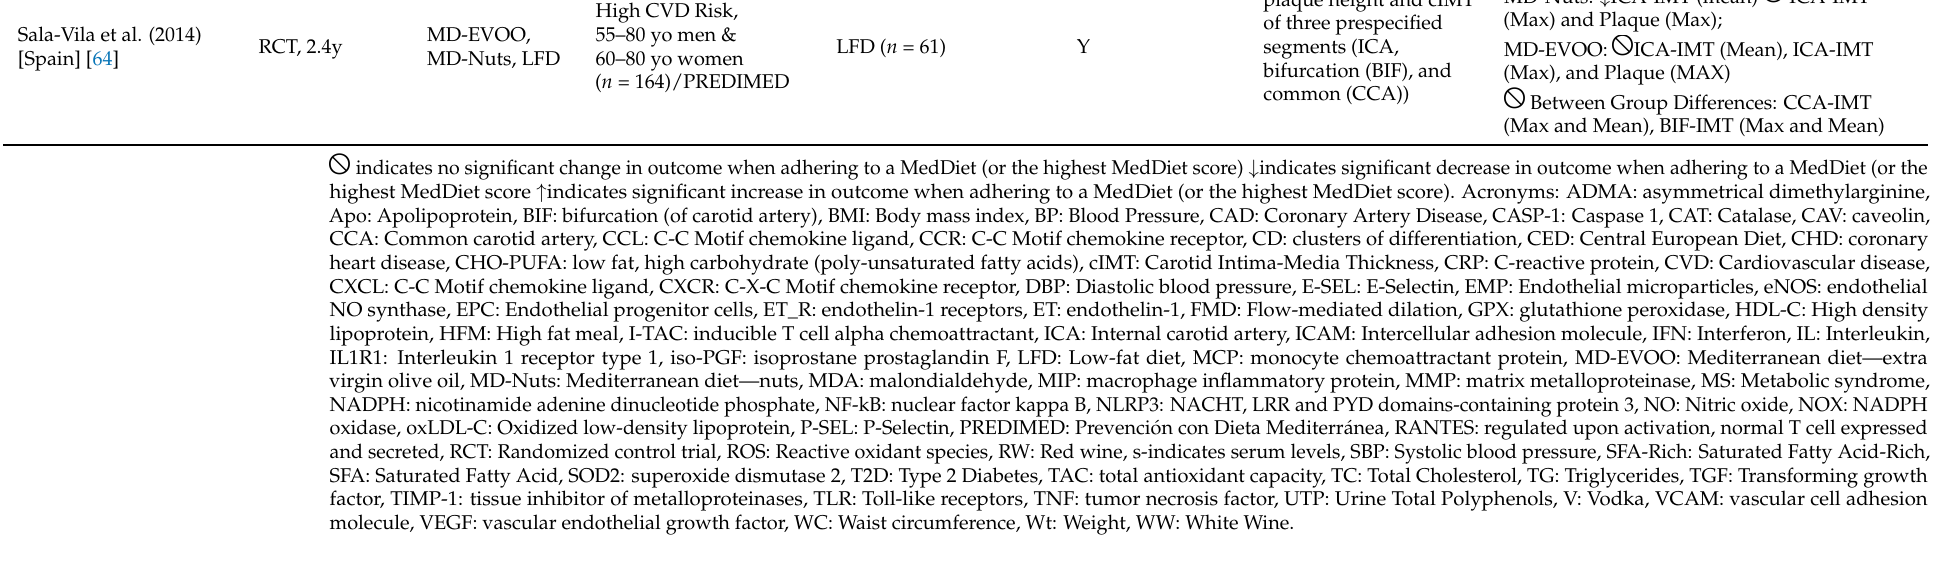
Table 2. Clinical Studies.